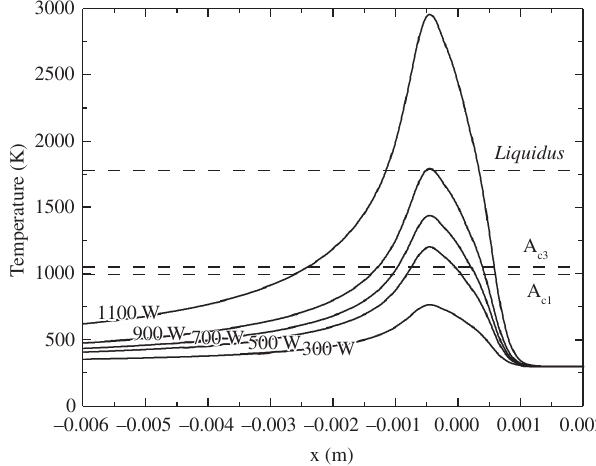
Figure 4. Calculated temperature profile at the surface for each power level as a function of the distance from the laser beam center. Pearlite-to-austenite transformation temperatures (Ac1 and Ac3) and the liquidus are also presented. All temperatures were calculated for a fixed point 50 µ m below the surface at track centerline and for a laser beam speed of 115 mm/s.